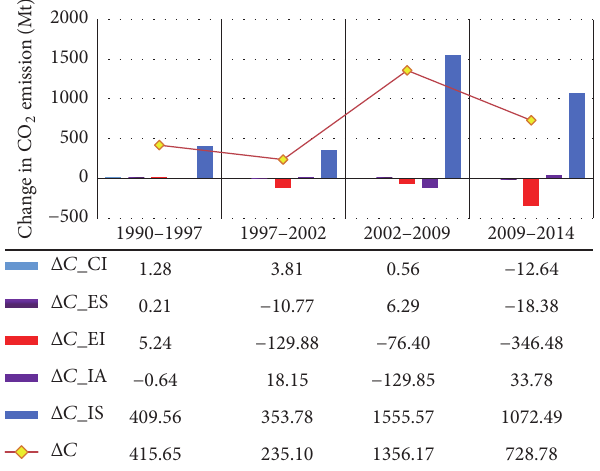
Figure 8: Driving factors to CO 2 emission change by time series in China’s power